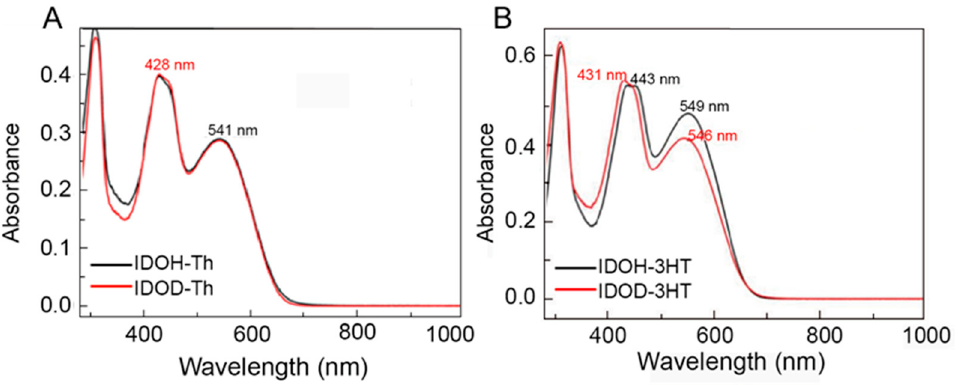
Figure 1. Absorption spectra of ( A ) IDOH–Th, IDOD–Th, and ( B ) IDOH–3HT, IDOD–3HT in CH 2 Cl 2 .